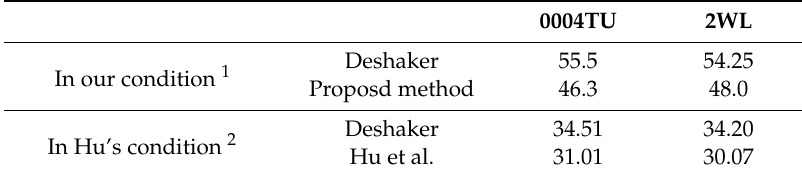
Table 3. Computational cost of video stabilization for various methods (ms / frame).